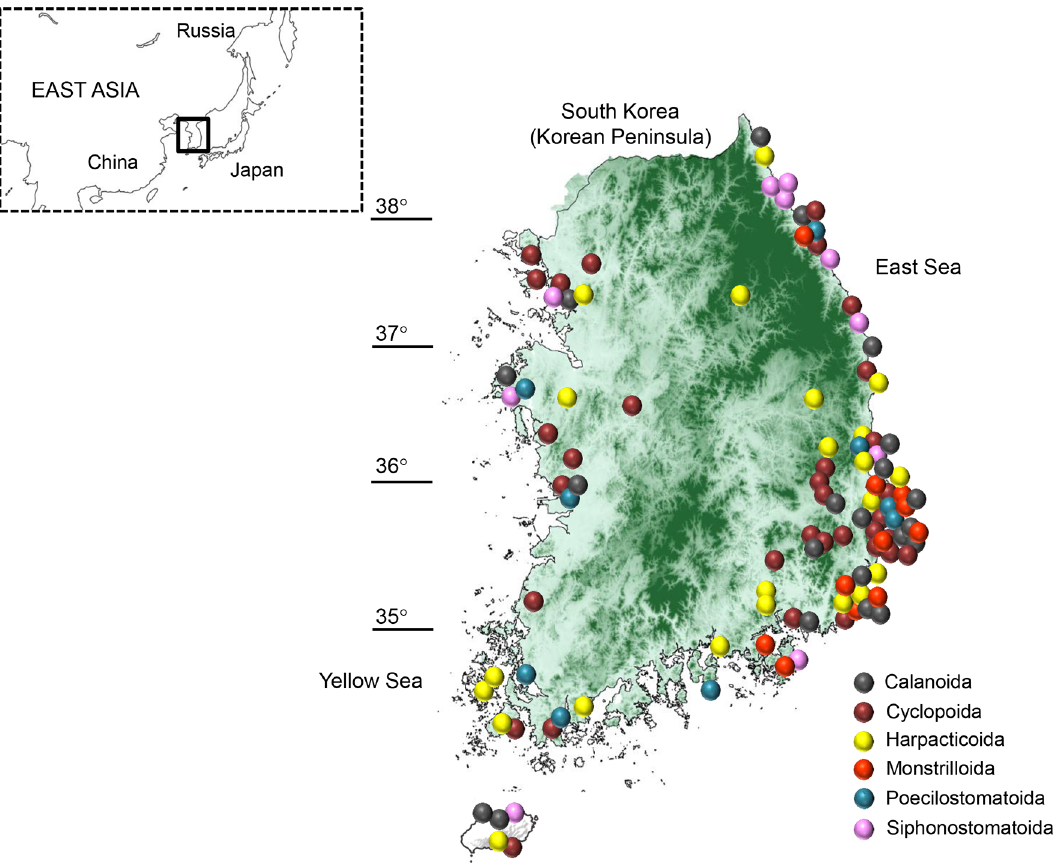
Fig 1. Collecting locations of 94 copepod species including the six orders used in the present